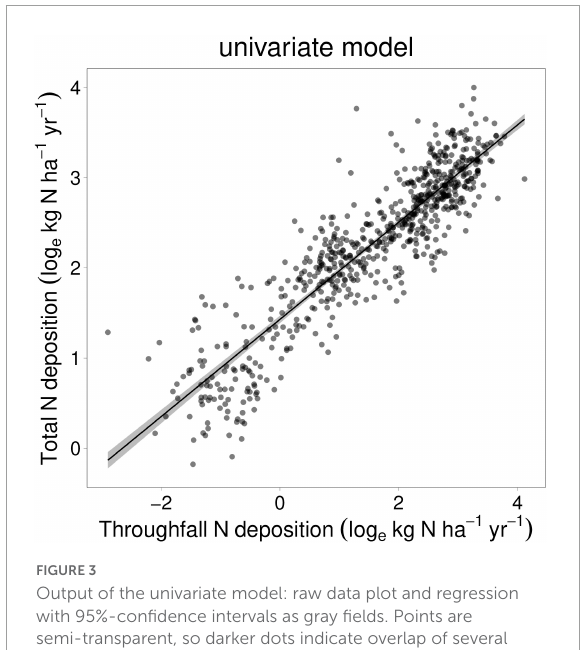
of modeled TD at high TF rates, we hypothesize that the data points with TD < TF (i.e., data points below the 1:1